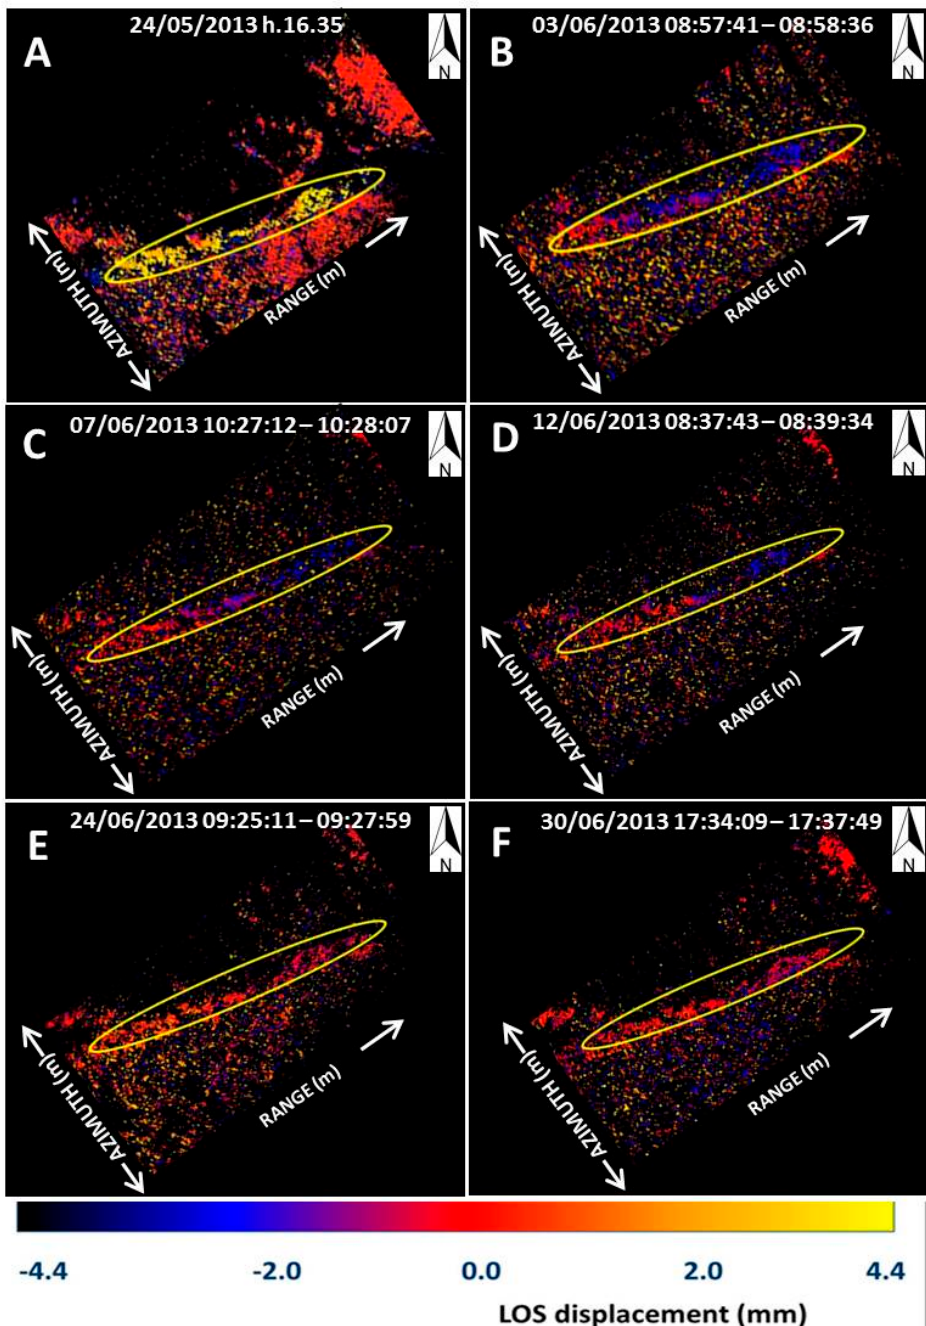
Figure 7. Interferograms (ITF) acquired in “fast mode”. The yellow oval represents the landslide body area. ( A ) 28 seconds ITF; about 14 m/day; ( B ) 55 seconds ITF; about 4 m/day; ( C ) 55 seconds ITF; about 3 m/day; ( D ) 1 minute and 52 seconds ITF; about 1.5 m/day; ( E ) 2 minutes and 48 seconds ITF; about 0.3 m/day; and ( F ) 3 minutes and 40 seconds ITF; about 0.2 m/day. Moreover, the GB-InSAR long-term monitoring campaign showed a sharp decrease of the toe velocities through the month of June until July 2013, from which the velocities reached daily millimeter values (Figure